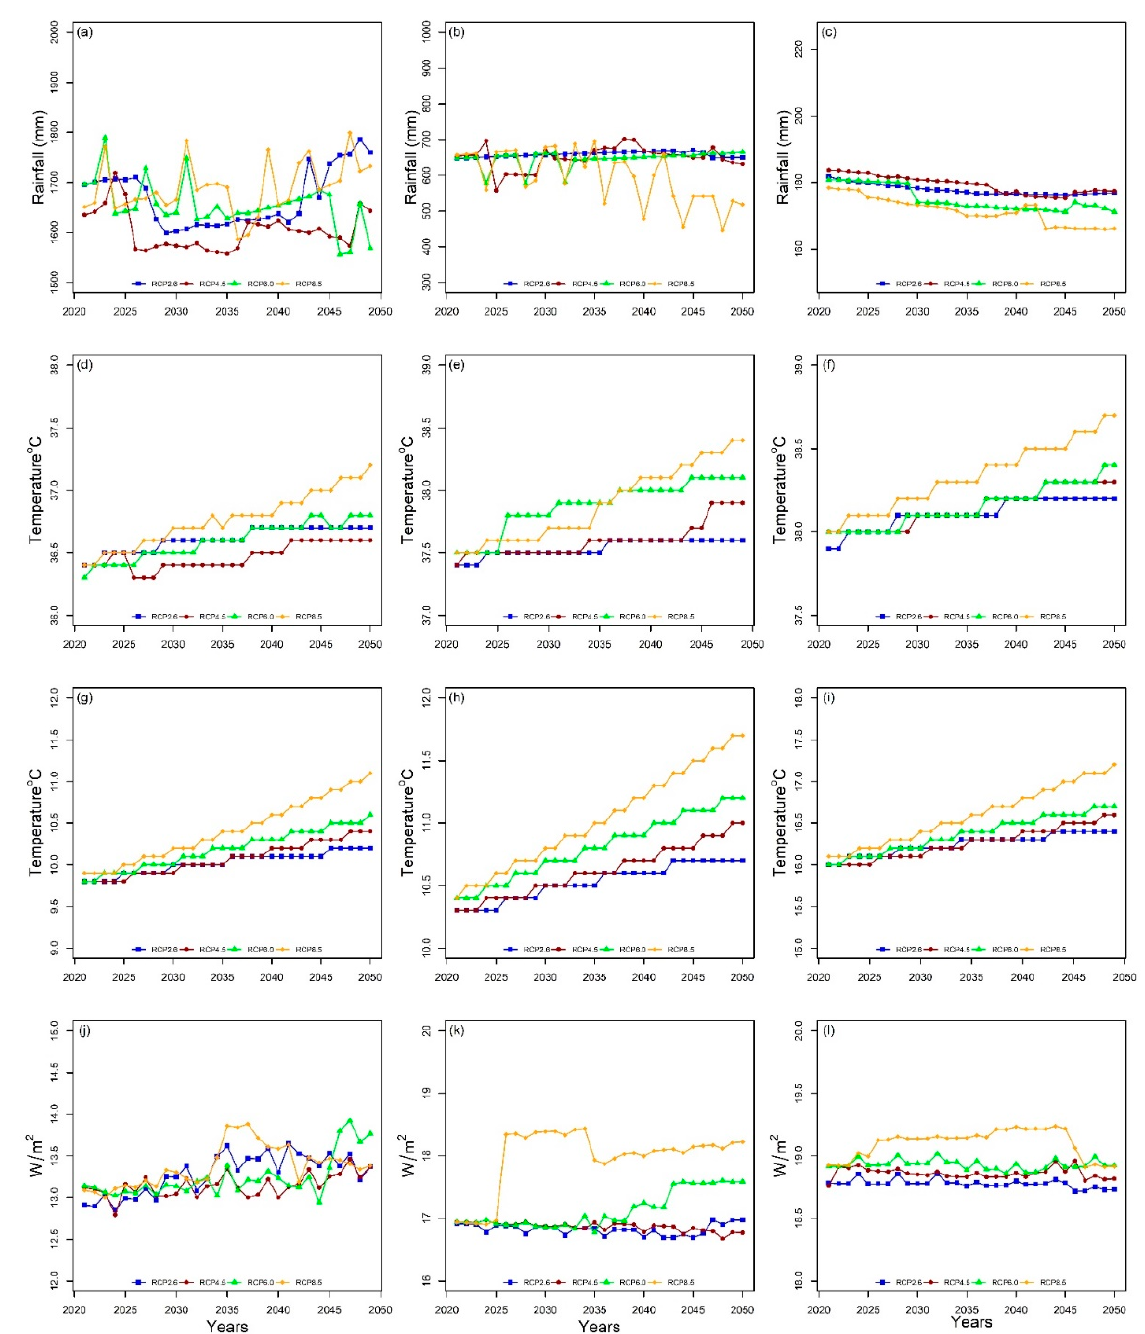
Figure 4. Future climate predictions under different scenarios in the wet season (left column), the first dry season (middle column), and the second dry season (right column). ( a ) Maximum temperature in the wet season, ( b ) minimum temperature in the wet season, ( c ) annual rainfall in the wet season, ( d ) solar radiation in the wet season, ( e ) maximum temperature in the first dry season, ( f ) minimum temperature in the first dry season, ( g ) annual rainfall in the first dry season, ( h ) solar radiation in the first dry season, ( i ) maximum temperature in the second dry season, ( j ) minimum temperature in the second dry season, ( k ) annual rainfall in the second dry season, and ( l ) solar radiation in the second dry season.